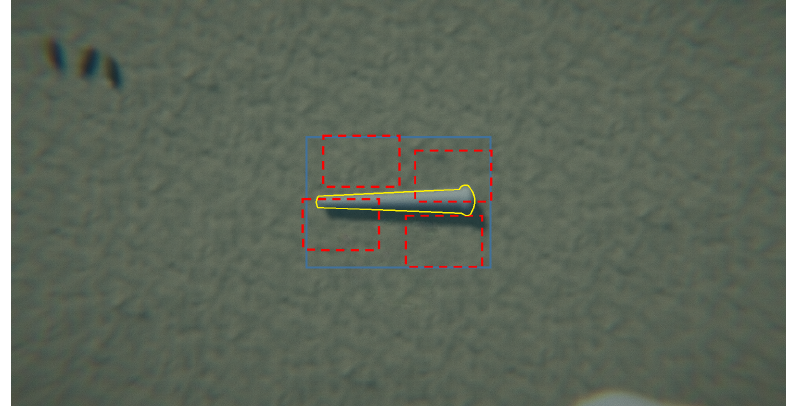
Figure 22. Vision phase 2: tracking and visual-servoing control to center the target in the on-hand camera view.